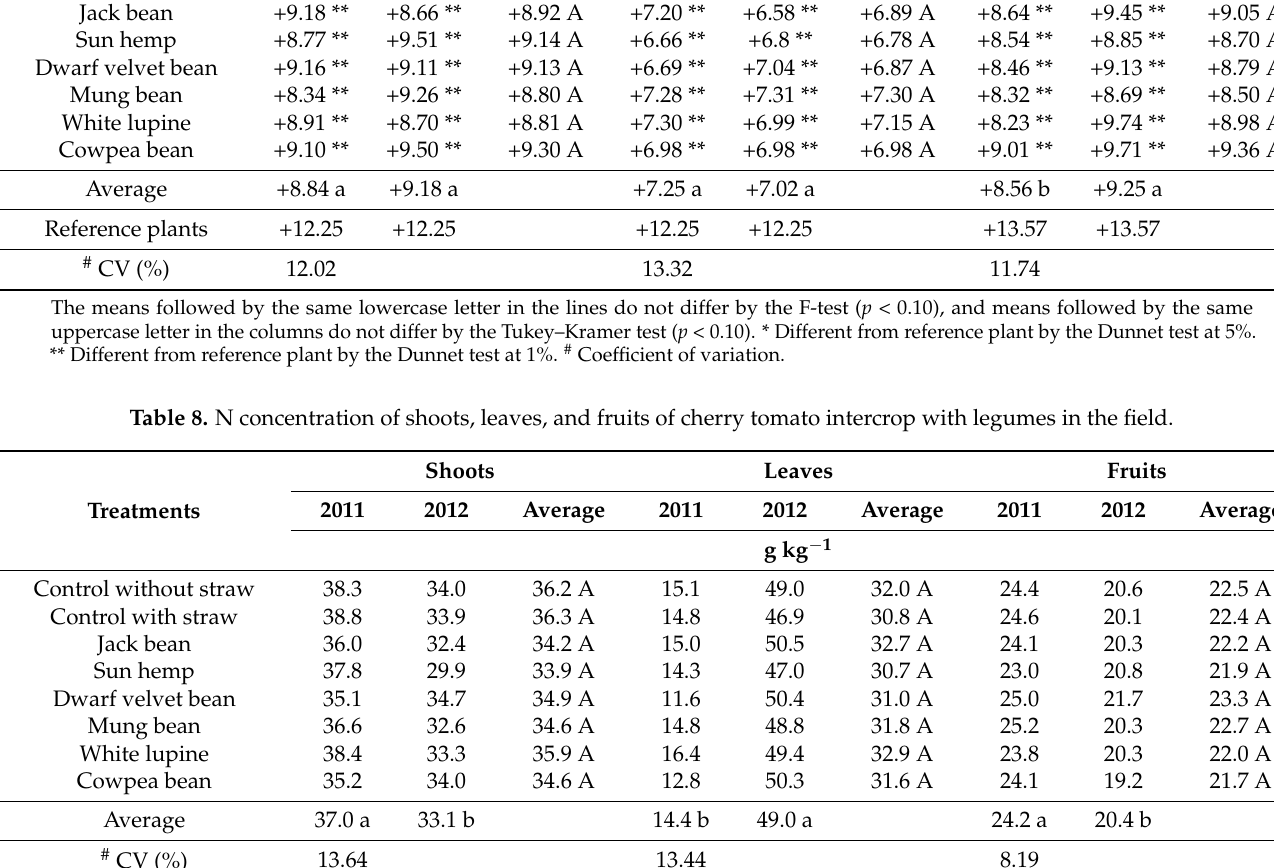
Table 7. The natural abundance of 15 N of shoots, leaves, and fruits of cherry tomato organic intercrop with legumes. Shoots Leaves Fruits 2011 2012 Average 2011 2012 Average 2011 2012 Average Treatments δ 15 N ‰ ( δ Air) Control without straw +8.82 ** +9.68 * +9.25 A +8.13 ** Control with straw +8.45 ** Jack bean Sun hemp Dwarf velvet bean Mung bean White lupine +8.91 ** Cowpea bean +9.10 ** Average +8.84 a Reference plants +12.25 +12.25 +13.57 # CV (%) 12.02